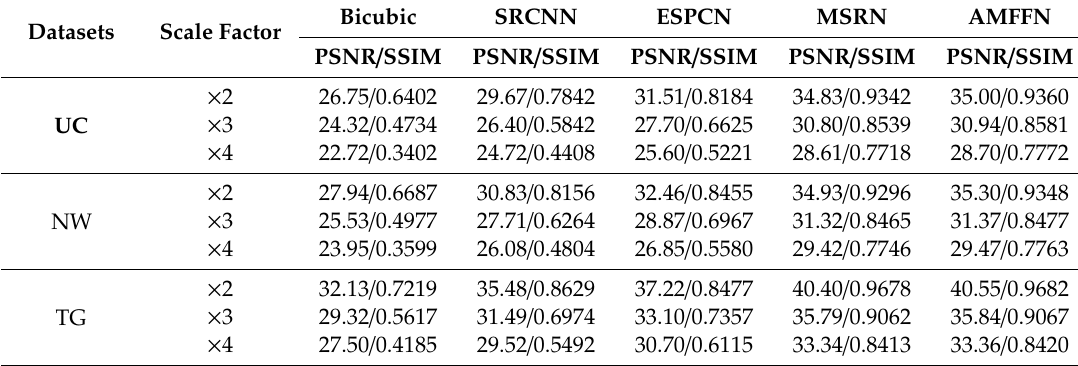
Table 4. Comparison results with other classical methods.